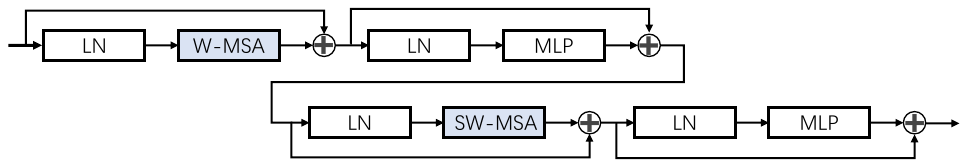
Figure 3. Blocks of two successive swin transformer blocks that use multi-head self-attention (MSA) modules with regular (W-MSA) and shifted windowing (SW-MSA) configurations. More details can refer to